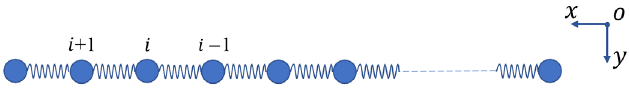
Figure 6. The simplified model of cable.